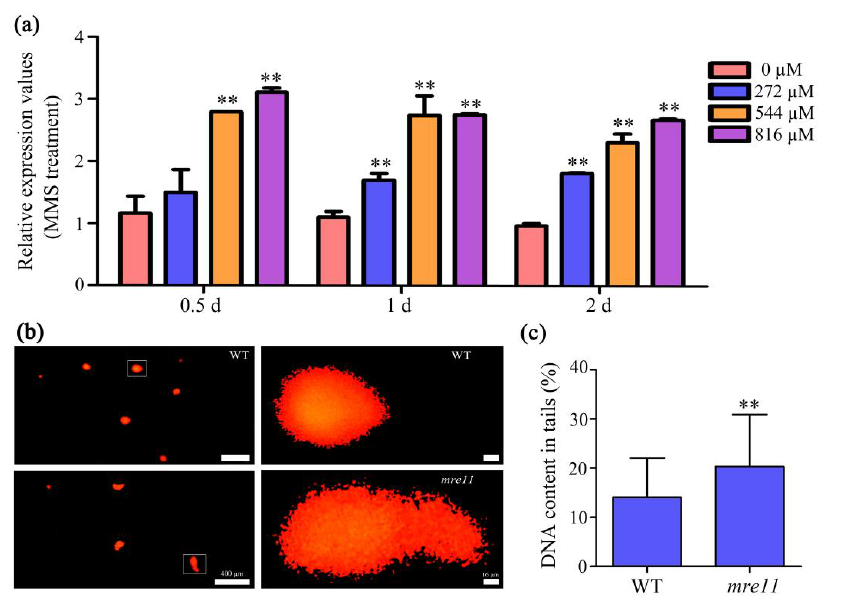
Figure 7. OsMre11 is involved in DNA damage repair of rice. ( a ) Relative expression level of OsMre11 in the 10DAG seedlings with the treatment of MMS reagent. The concentration of MMS was 0, 272, 544, and 816 µM, respectively. Materials were collected after the treatment of 0.5, 1, and 2 days. ( b ) Pictures of comet assay in the 10DAG seedling roots of WT and mre11 . The images on the right are magnified images in the white boxes on the left. Scale bars represent 400 µm on the left and 16 µm on the right. ( c ) The DNA contents of the tail of nuclei in root cells of WT and the mre11 seedlings. The numbers of WT and the mre11 are 82 and 76, respectively. The two asterisks represent a statistically signifi cant difference according to Student’s t -test (**, p < 0.01).